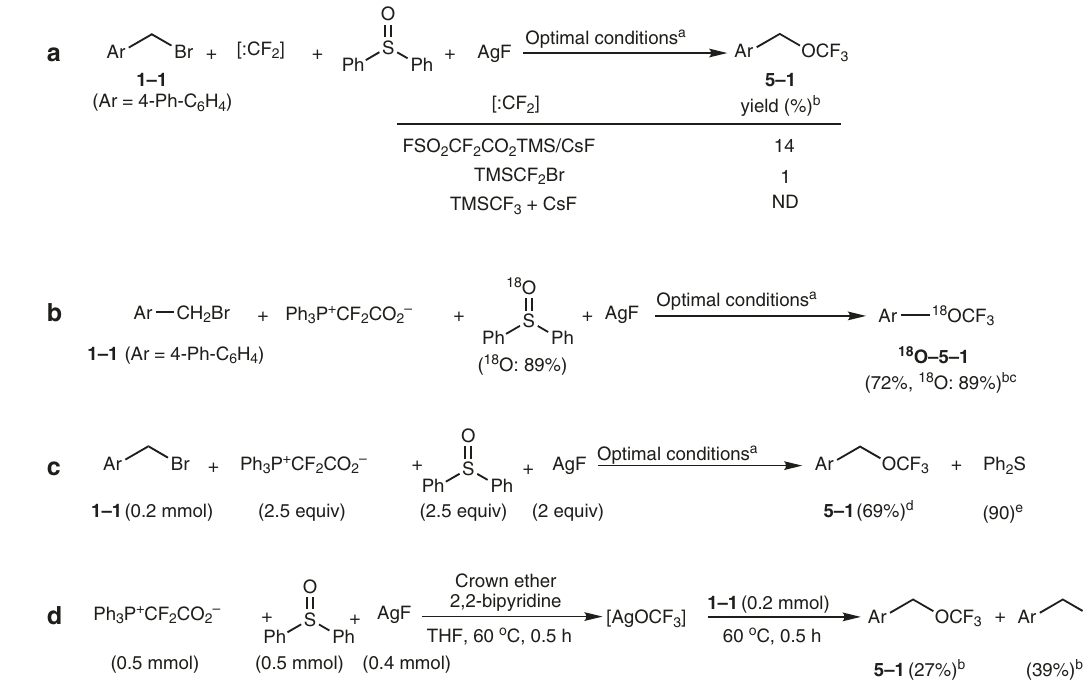
Fig. 2 Mechanistic investigation. a The use of other di fl uorocarbene reagents for tri fl uoromethoxylation. b The identi fi cation of the oxygen source by 18 O-labeling. c The identi fi cation of the oxygen source by isolating Ph Table 1, entry 21: substrate 1 (0.2 mmol), Ph 3 P + CF 2 CO 2 − (2.5 equiv), Ph 2 S = O (2.5 equiv), AgF (2 equiv), 2,2 ′ -bipyridine (1.5 equiv), and 2,3,11,12-dibenzo- 18-crown-6 (0.5 equiv) in THF (1.5 mL) at 60 °C for 0.5 h; b Yields were determined by 19 F NMR spectroscopy. c The 18 O content was determined by EI-MS. d Isolated yield calculated based on substrate 1 – 1 . e Isolated yield based on Ph